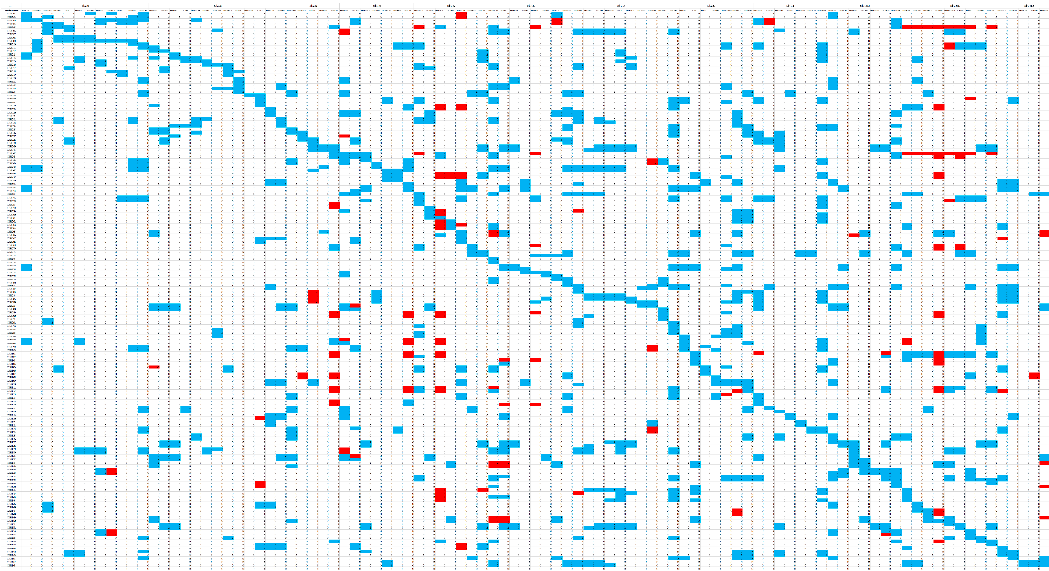
Figure 3. Graphical genotypes of 163 CSSLs with C-bao as a receptor parent and Ludao as a donor parent in rice. Note: Blue, white, and red represents the genotype of Ludao, C-bao, and missing band, respectively.